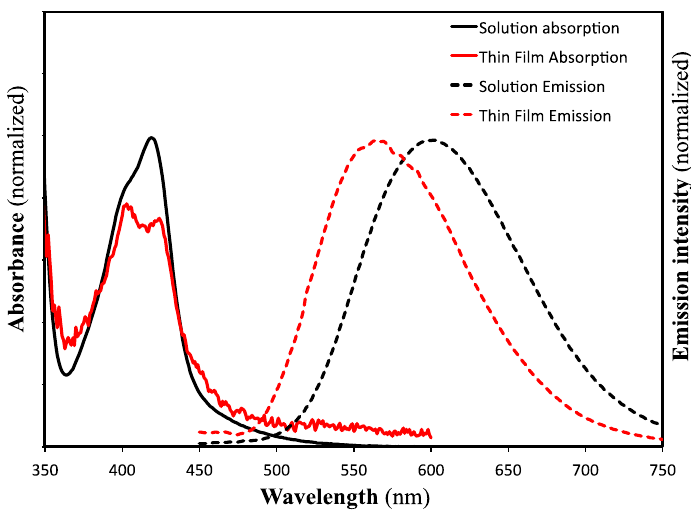
Figure 2. UV-visible absorption and emission spectra of 2a in solution (10 − 5 M CHCl 3 ) and as thin films. Emission spectra were obtained using an excitation wavelength of 420